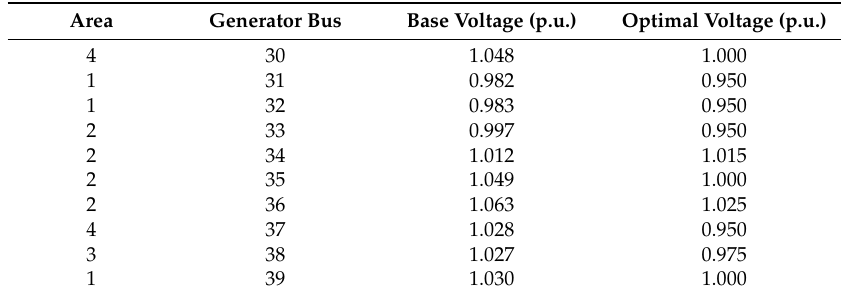
Figure 8. Distributed control: post-game theoretic (GT) Area 1 voltage profile. Table 3. Equilibrium generator settings for all